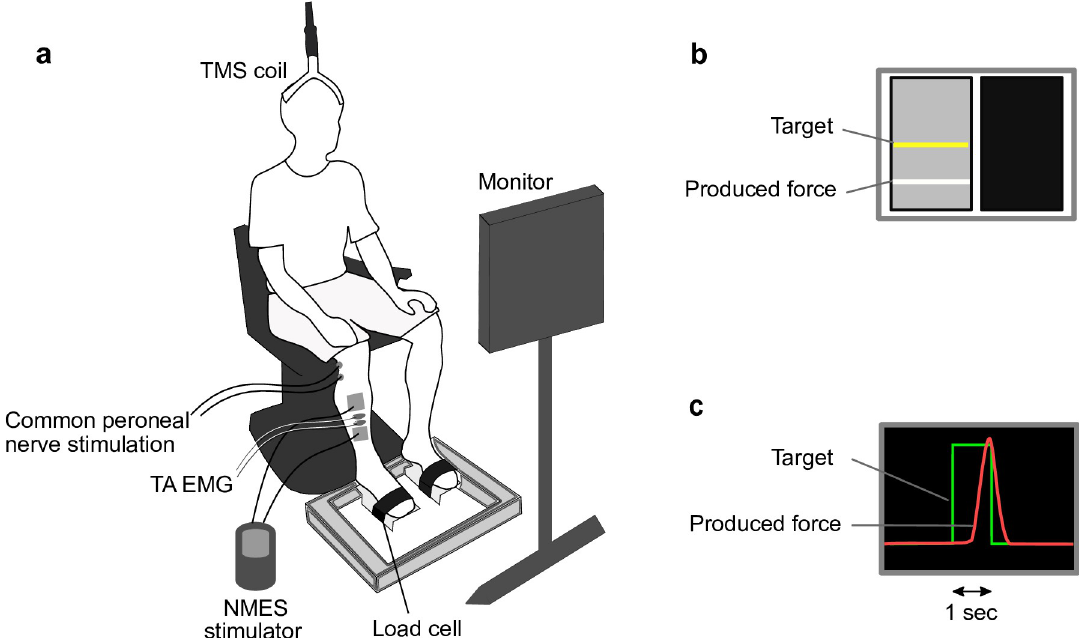
Fig 1. Experimental setup. (a) NMES was applied on the right TA during ON period (5 s). During OFF period (19 s), TMS and peripheral nerve stimulation were applied; (b) Participants were instructed to match the ankle dorsiflexor force to a target when the panel changed to the ON signal (black screen). The yellow line represented the target. Visual force feedback was presented using a white line; and (c) Force-matching task consisted of right leg isometric ankle dorsiflexion during 1 s contractions. The green line represented the target. Visual force feedback was presented using a red line. Abbreviations: EMG, electromyography; NMES, neuromuscular electrical stimulation; TA, tibialis anterior; TMS, transcranial magnetic